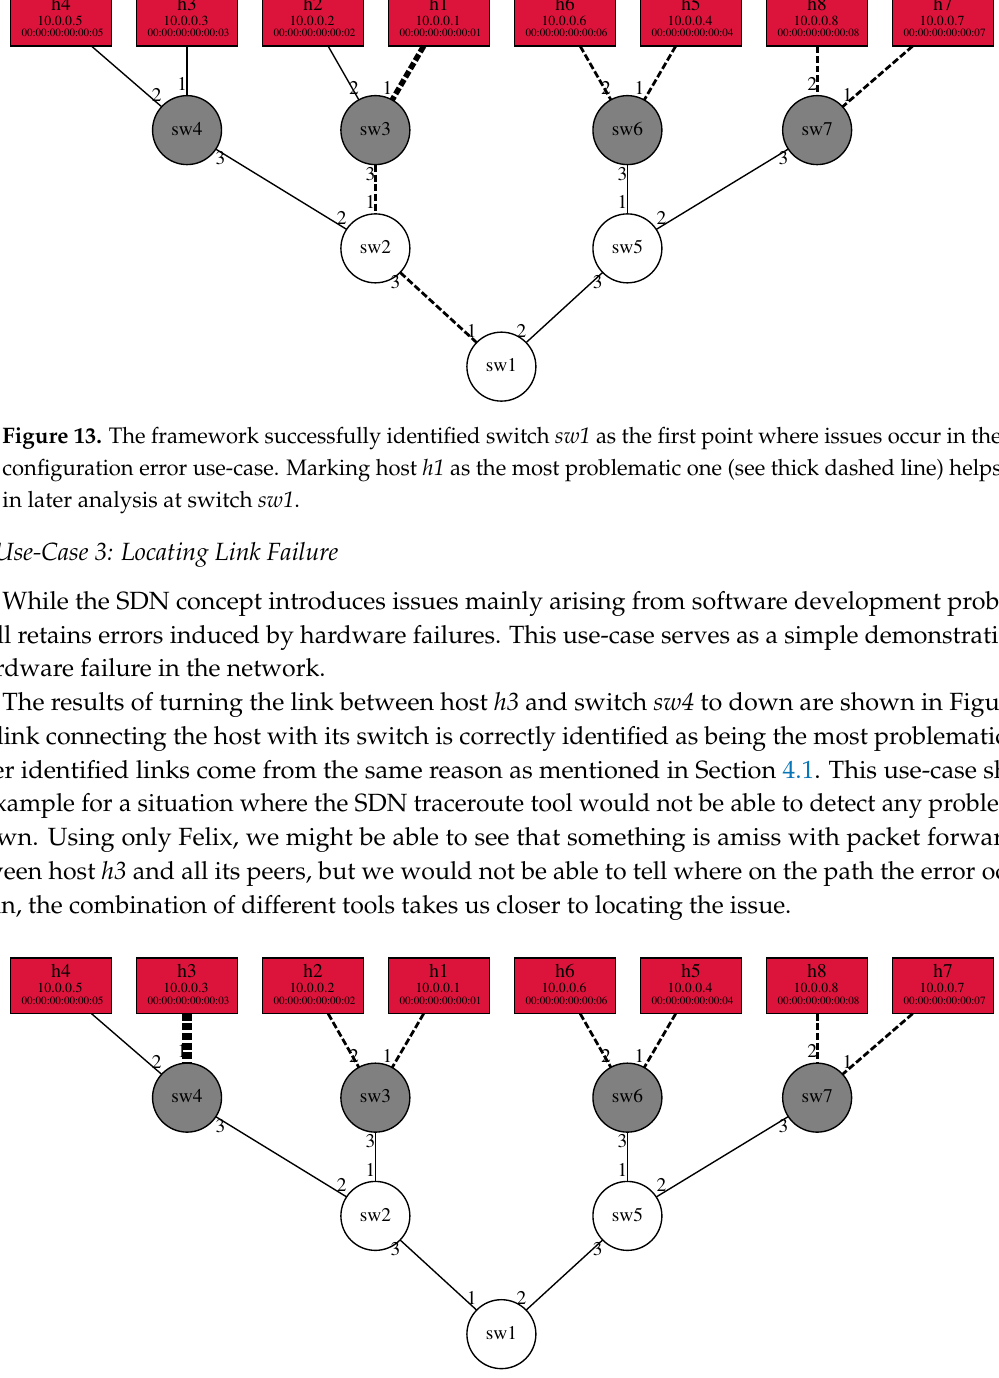
Figure 14. Our framework’s display of detected links that are affected by issues in the link failure use-case. The thick line between h3 and sw4 indicates that the connection is the most likely to have